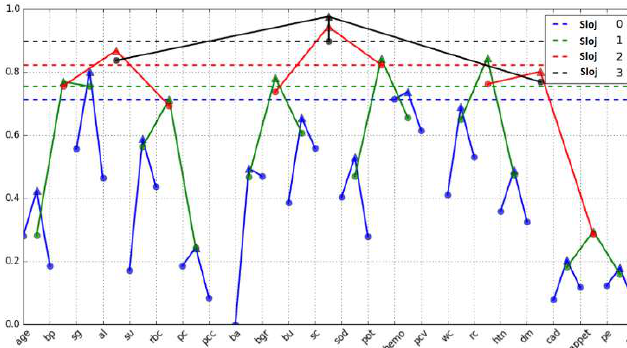
Figure 12 . Mutual information values in the network